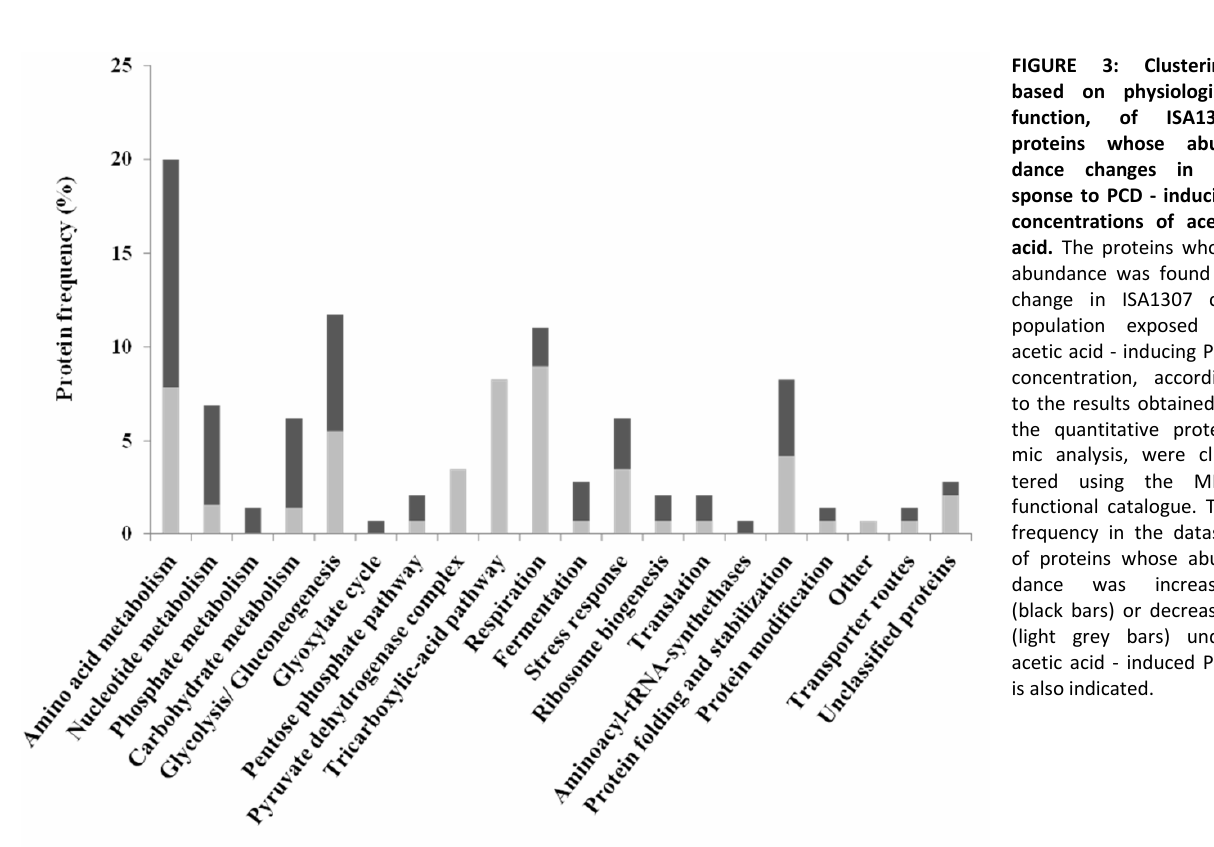
3: Clustering, based on physiological function, of ISA1307 proteins whose abun- dance changes in re- sponse to PCD - inducing concentrations of acetic acid. The proteins whose